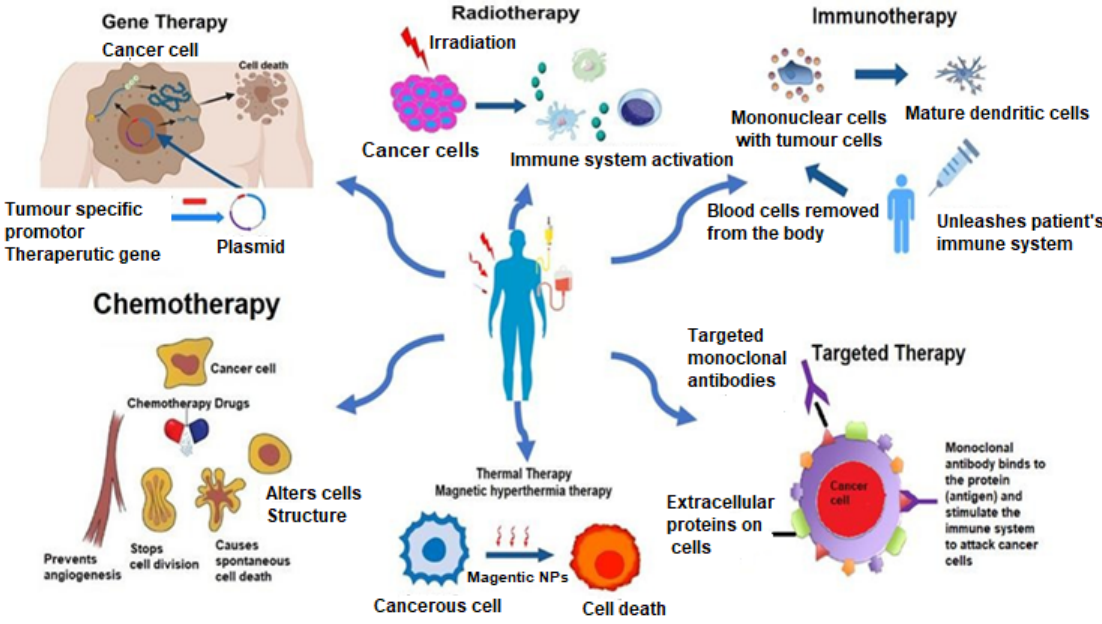
Figure 2. Allopathic treatment involved in cancer therapy. Table 3. List of various treatment modalities for cancer.